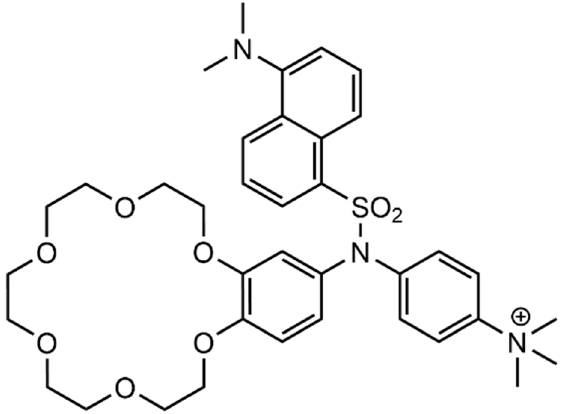
Figure 24. Structure of the crown ether and trimethylammonium sensor, CENMe 3 [154].